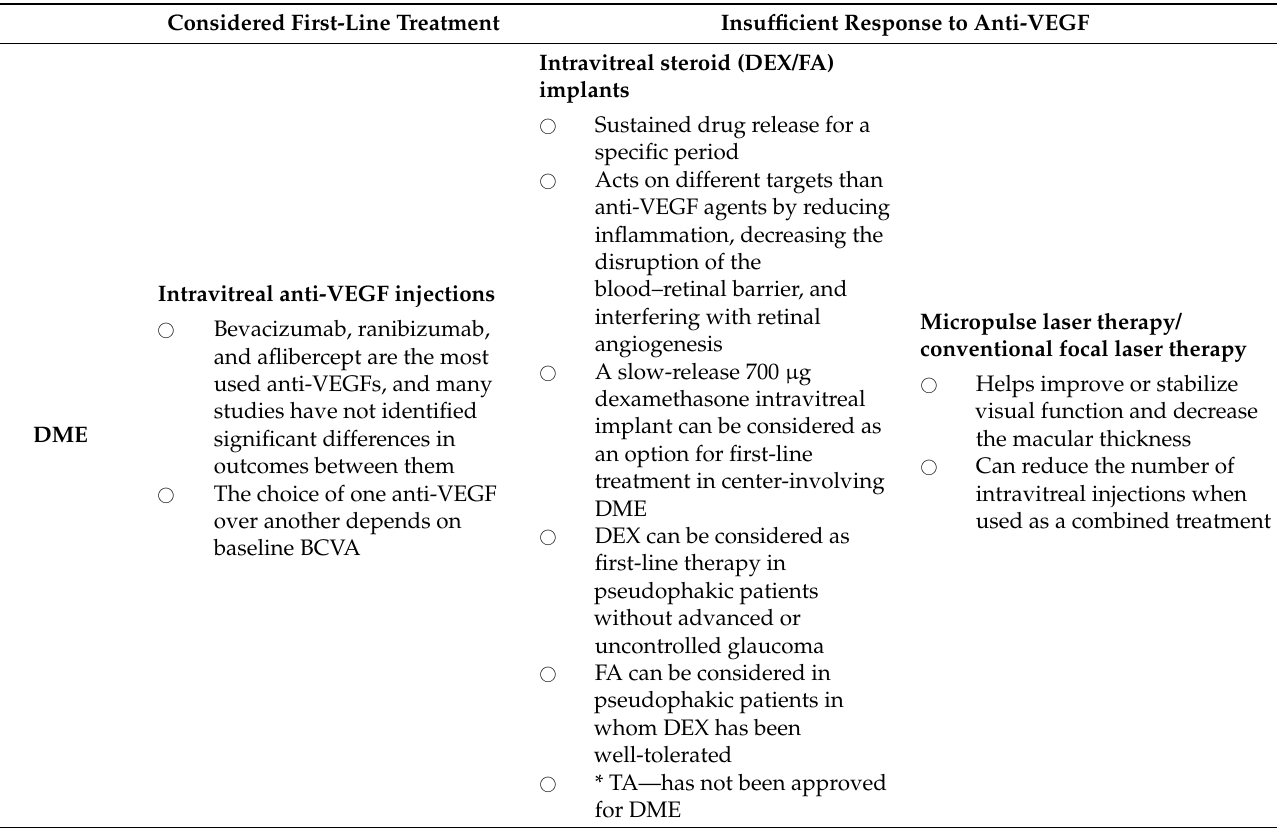
Table 1. Summary of treatment of diabetic macular